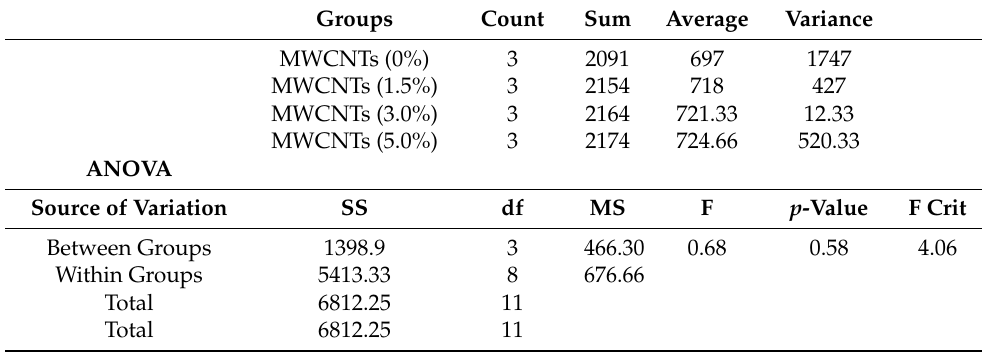
Table 4. Density values of MWCNTs-UF MDF for various iterations.